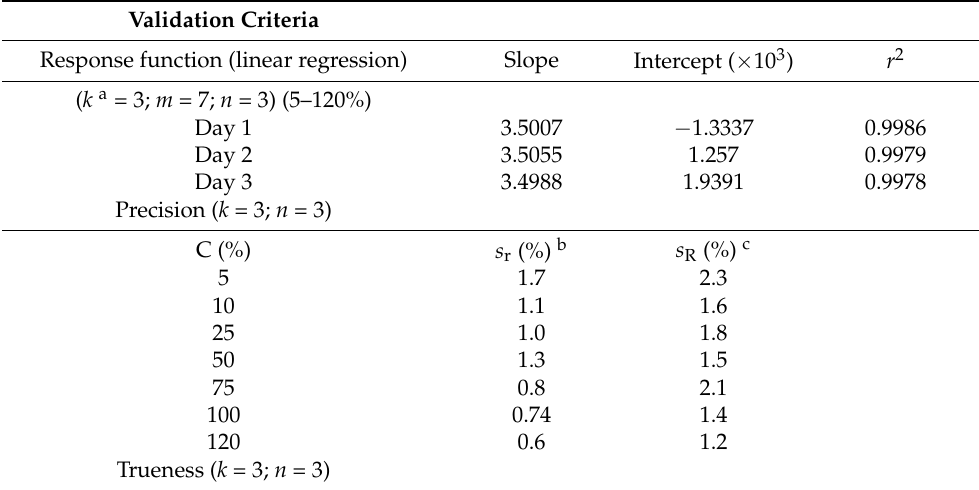
Figure 2. Accuracy profiles for the CAP determination using a ( A ) linear unweighted regression model using one standard at the highest concentration level (120%) and ( B ) linear unweighted regression model. The red plain, blue dashed and blank dotted lines correspond to the relative error (%), the accuracy profile and the acceptance limits λ ( ± 10%), respectively. Table 1. Validation results for the determination of CAP in the in vitro dissolution